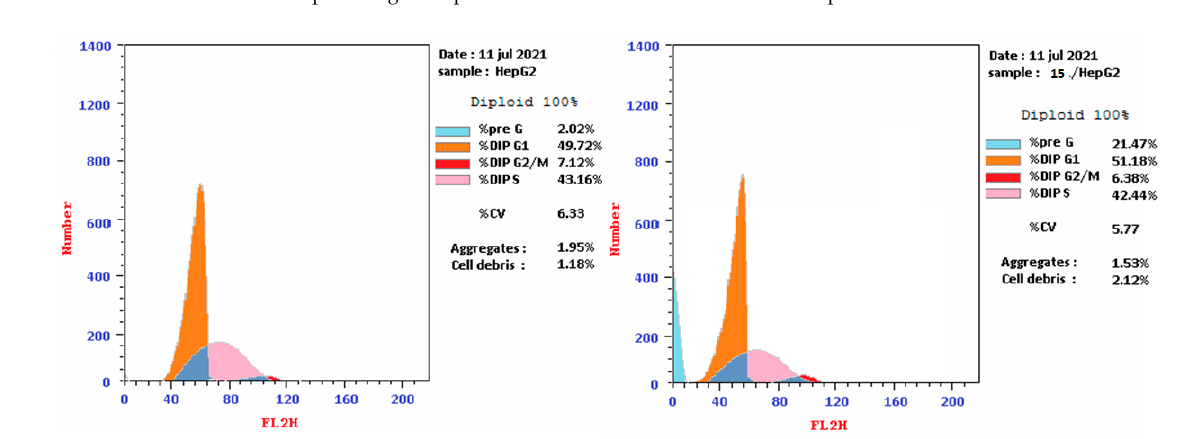
Figure 6. Flow cytometric analysis of cell cycle phases following treatment with compound 15.